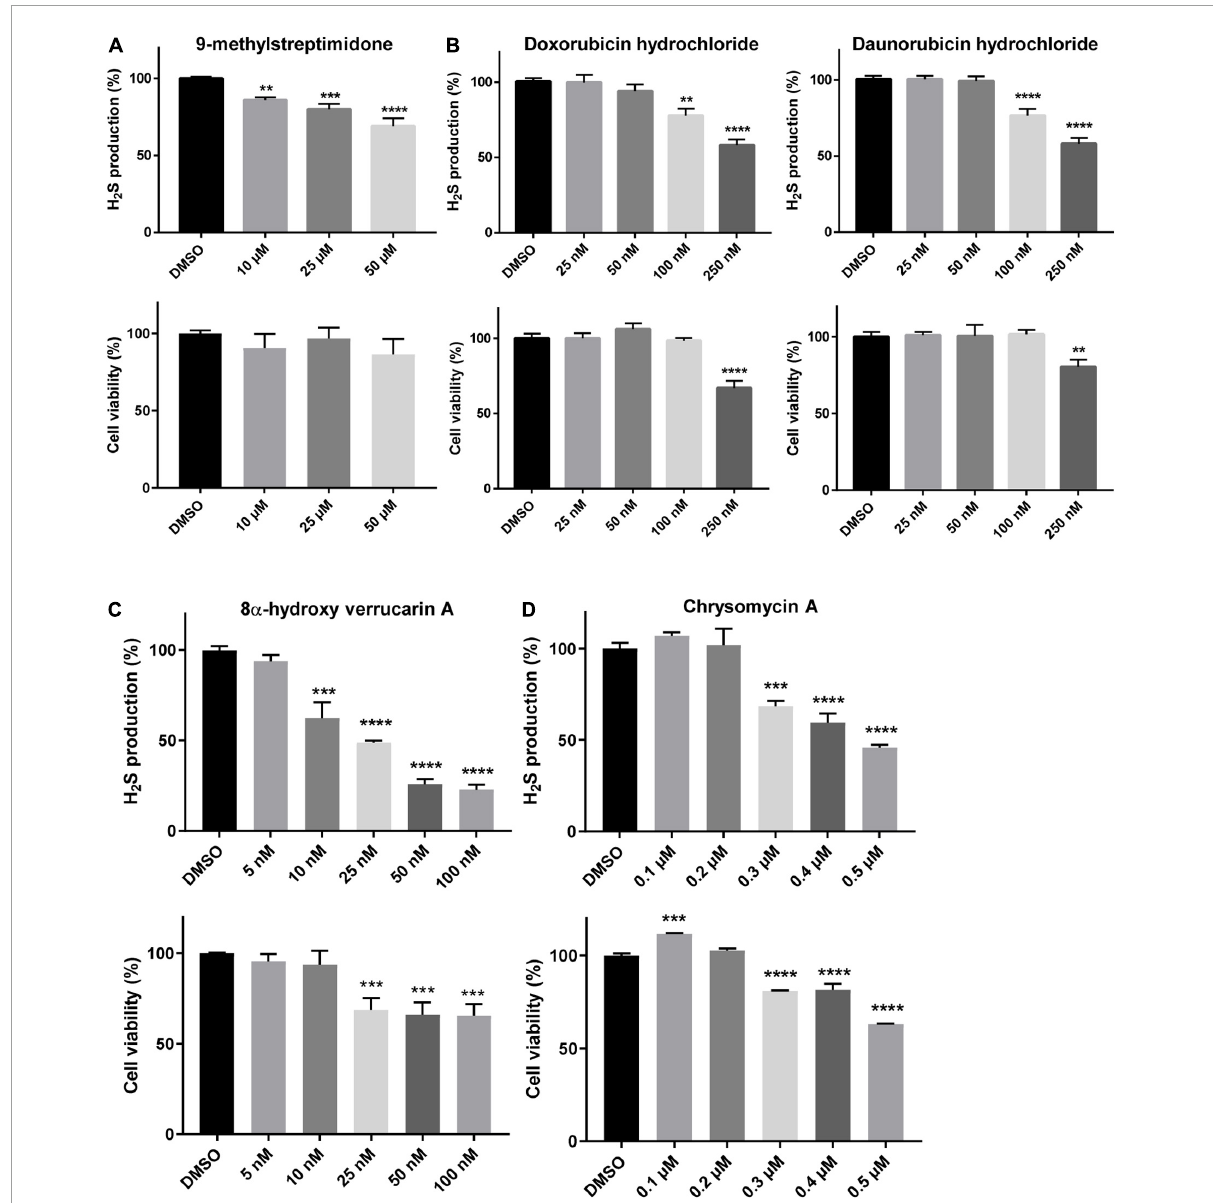
FIGURE3 Molecules reducing the phenotypes induced by CYS4 -OE decrease H 2 S production. The level of H 2 S production and cell viability were assessed using the Azido-4-Methylcoumarin (AzMC) probe and the WST-8 assay, respectively. A 24 h-treatment of HepG2 cells with 9-methylstreptimidone (A) , doxorubicin and daunorubicin hydrochloride (B) , 8 α -hydroxy verrucarin A (C) , and chrysomycin A (D) , resulted in decreased H 2 S production (upper panels) without decreasing cell viability, except at the highest concentrations tested (lower panels). Comparison of each condition with DMSO, one-way ANOVA with Dunnett’s post-hoc test: ** p < 0.01; *** p < 0.001, **** p <